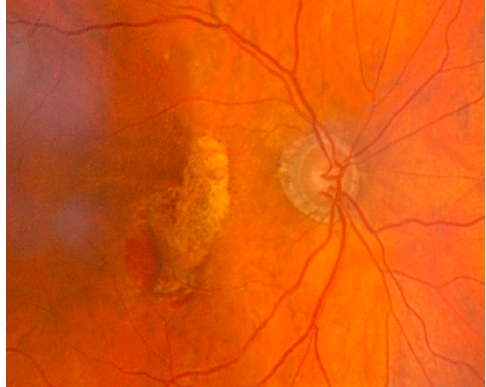
Figure 5. Exudative age-related macular degeneration with parafoveal neovascular component localized inferiorly in the area of intraretinal hemorrhage. The area of atrophy of the retinal pigment epithelium in the macular and superior paramacular sites. The exact pathological mechanisms leading to the different forms of AMD are still unclear. Oxidative stress and inflammation seem to play a major role in both AMD and aging, leading to the formation of abnormal extracellular matrix. This event results in altered behavior of RPE choriocapillaries, ultimately leading to atrophy of the retina, RPE, and choriocapillaries, which is paralleled by neovascularization of the choroid.